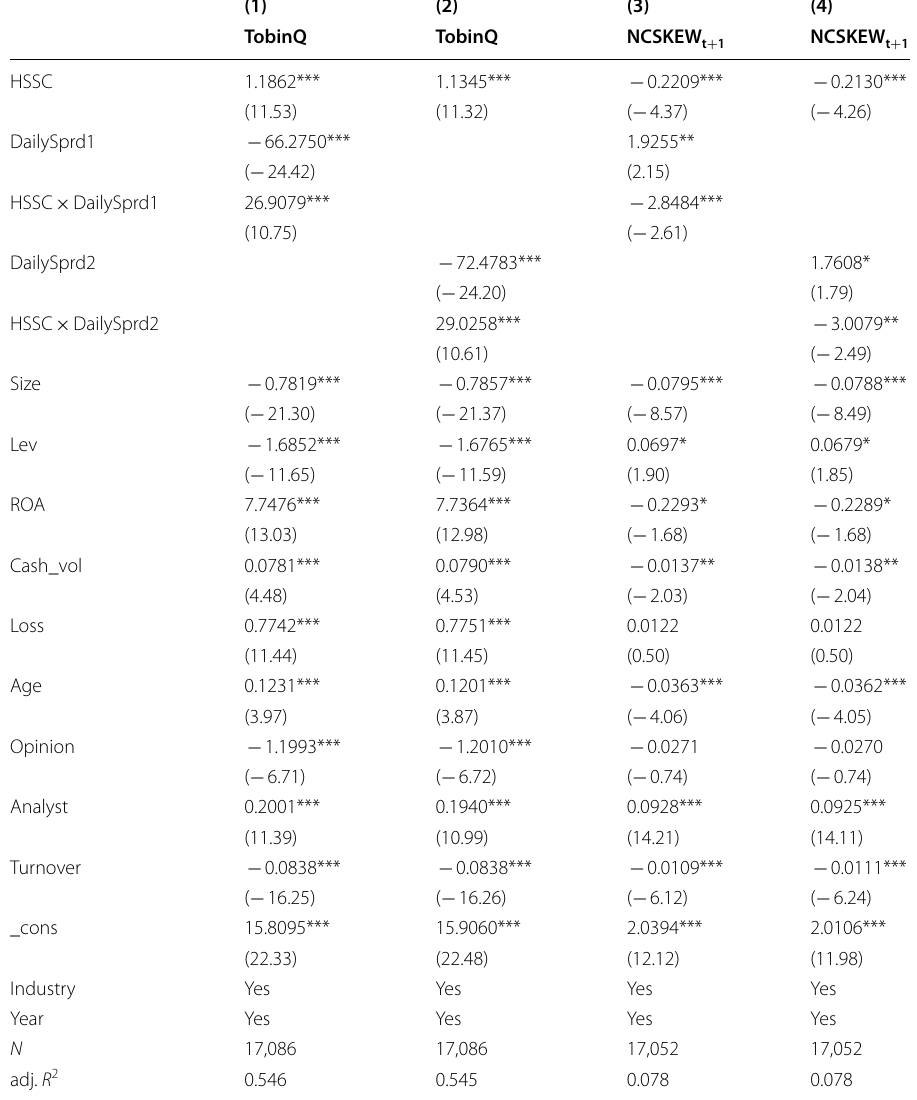
Table 5 Further analysis: firm-level economic